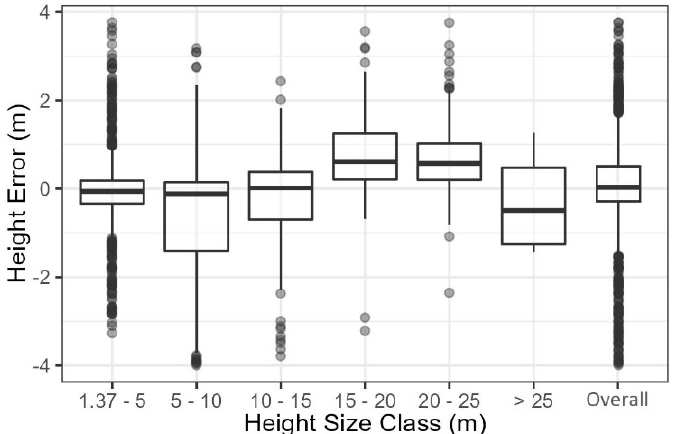
Figure 3. SfM extracted tree height errors.